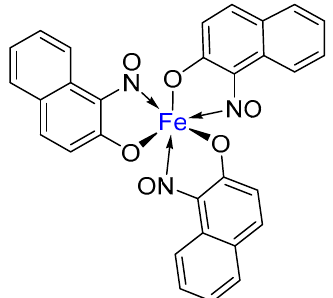
Figure 1. The molecular structure of the commercially available dye, ‘Pigment green 8’ (aka ‘Pigment Green B’) [6].